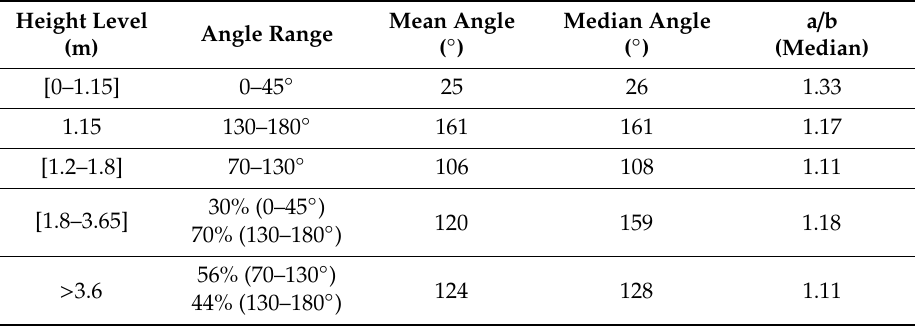
Table 2. Ellipse orientation for each range of